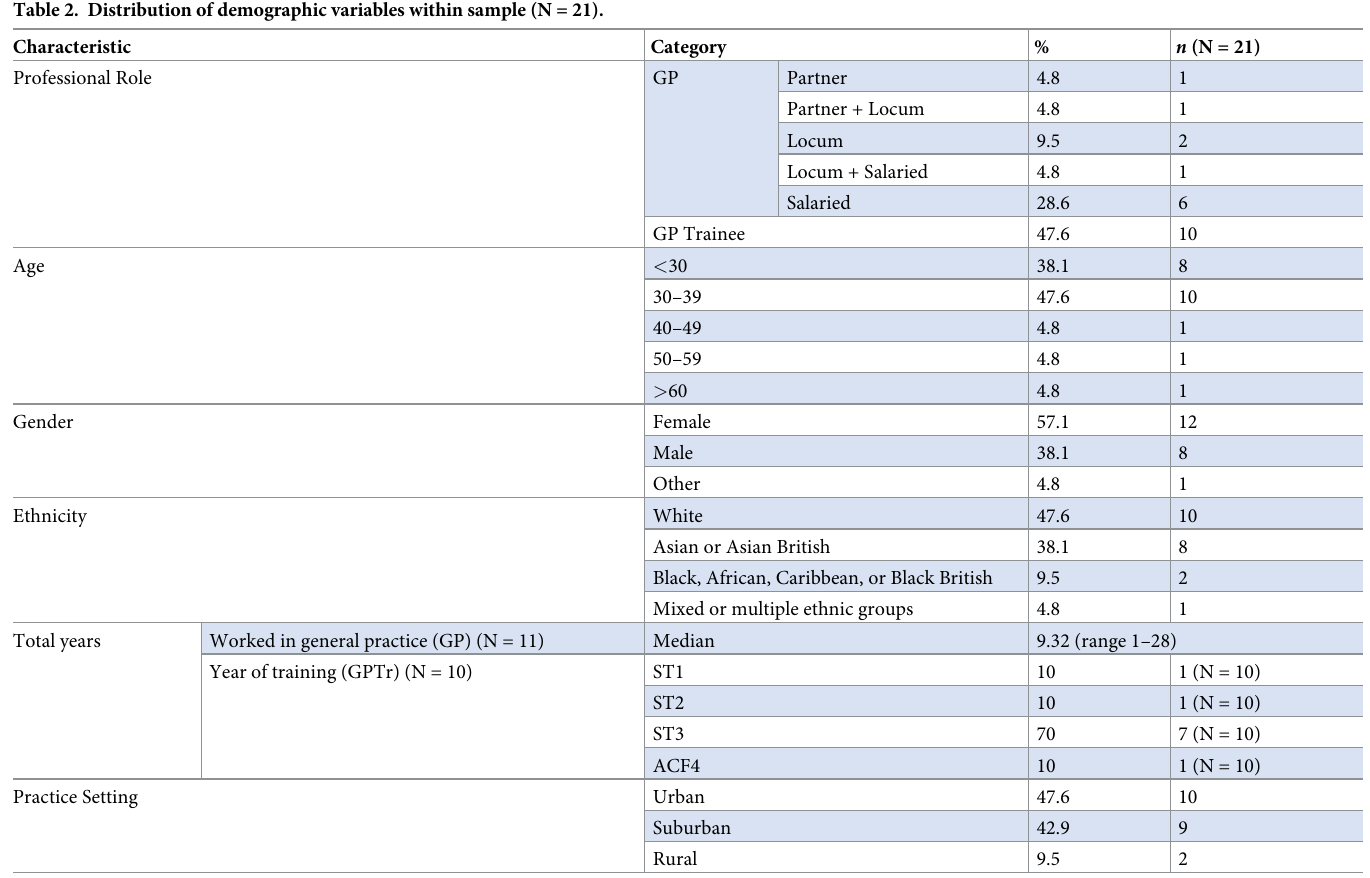
Table 2. Distribution of demographic variables within sample (N =